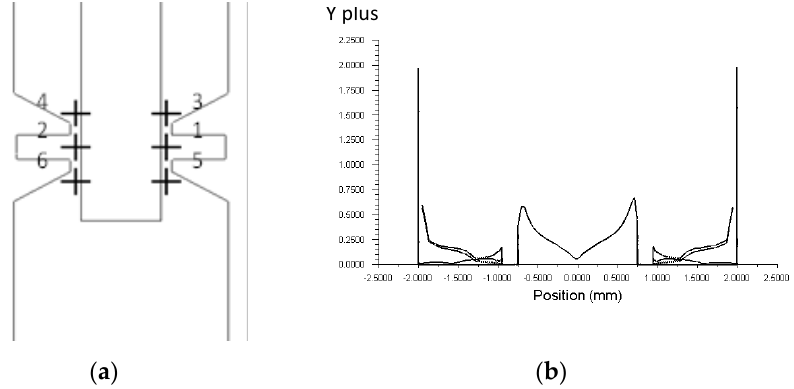
Figure 4. Nozzle structure with observation points and the Y plus distribution. ( a ) Nozzle structure with observation points. ( b ) The Y plus distribution when velocity of inlet is 10 m/s.